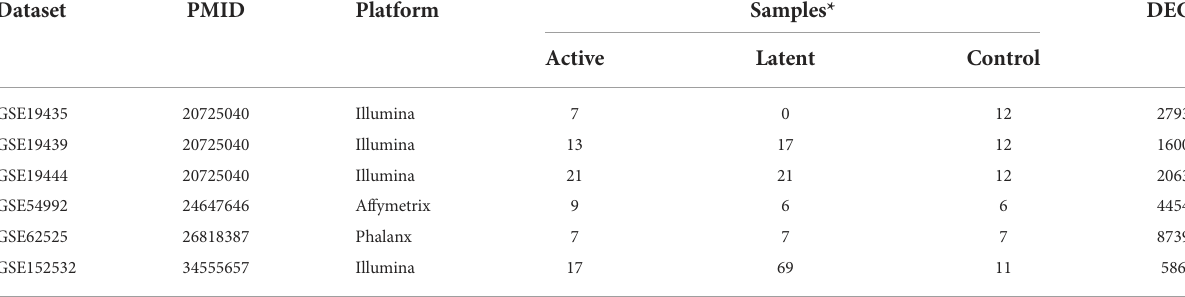
TABLE 1 List of GEO datasets used in the meta-analysis. Dataset